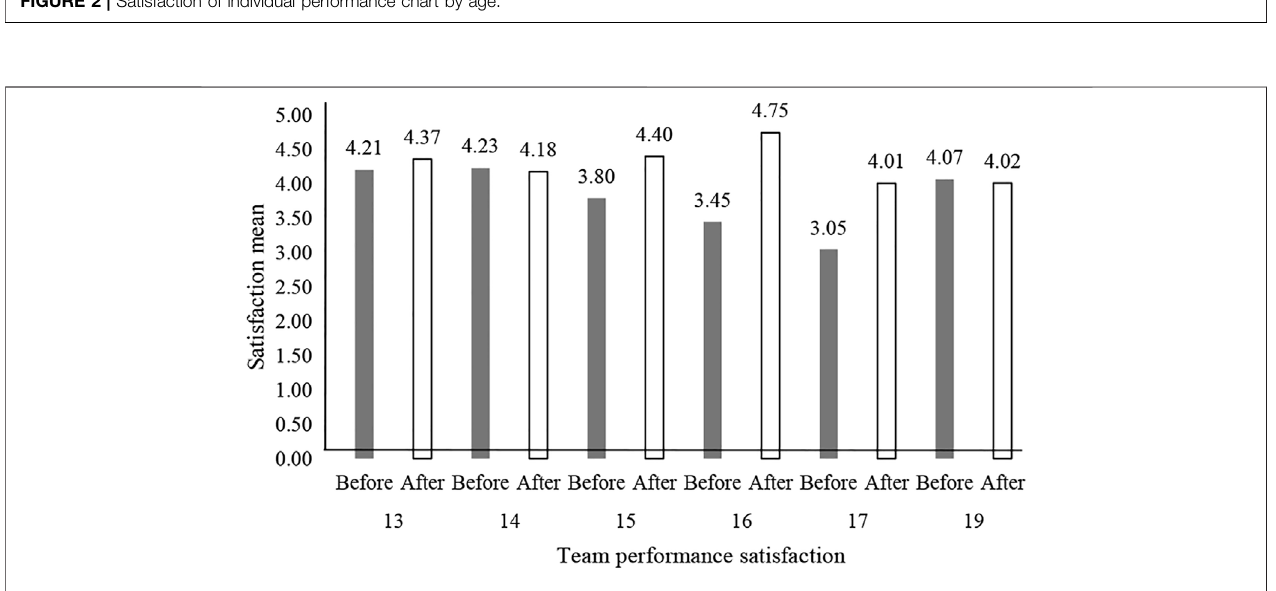
FIGURE 3 | Satisfaction of team performance chart by age.